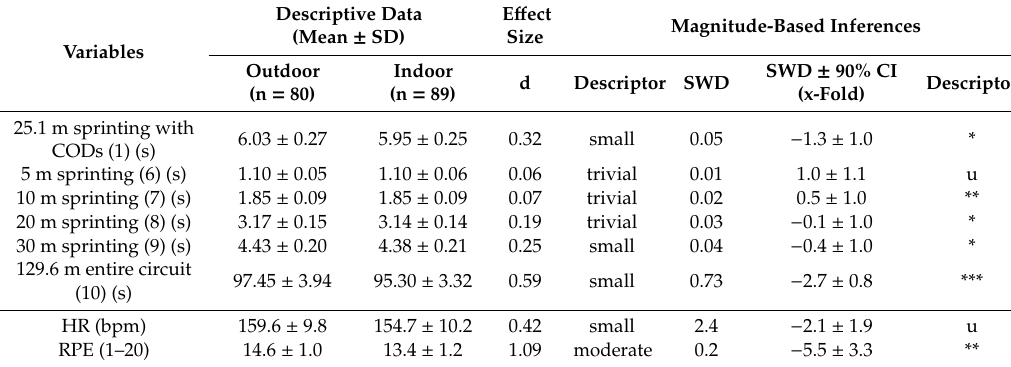
Table 1. Timing gate and physiological data of the athletes during outdoor and indoor conditions.